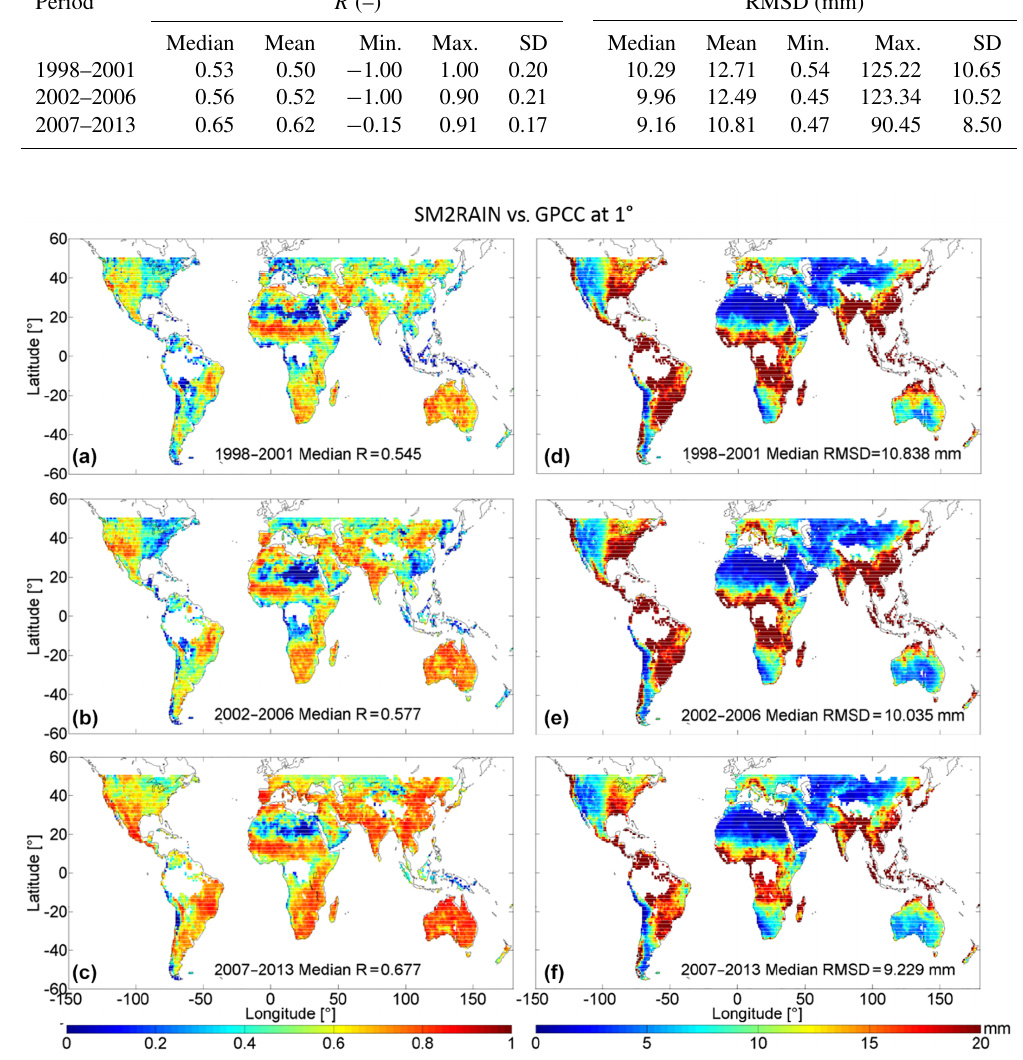
Figure 4. Global Pearson correlation (left column) and root mean square difference (right column) maps obtained between GPCC-FDD and the SM2RAIN-CCI rainfall data set for 5-day accumulated rainfall during the periods 1998–2001 (a, d) , 2002–2006 (b, e) and 2007– 2013 (c, f)